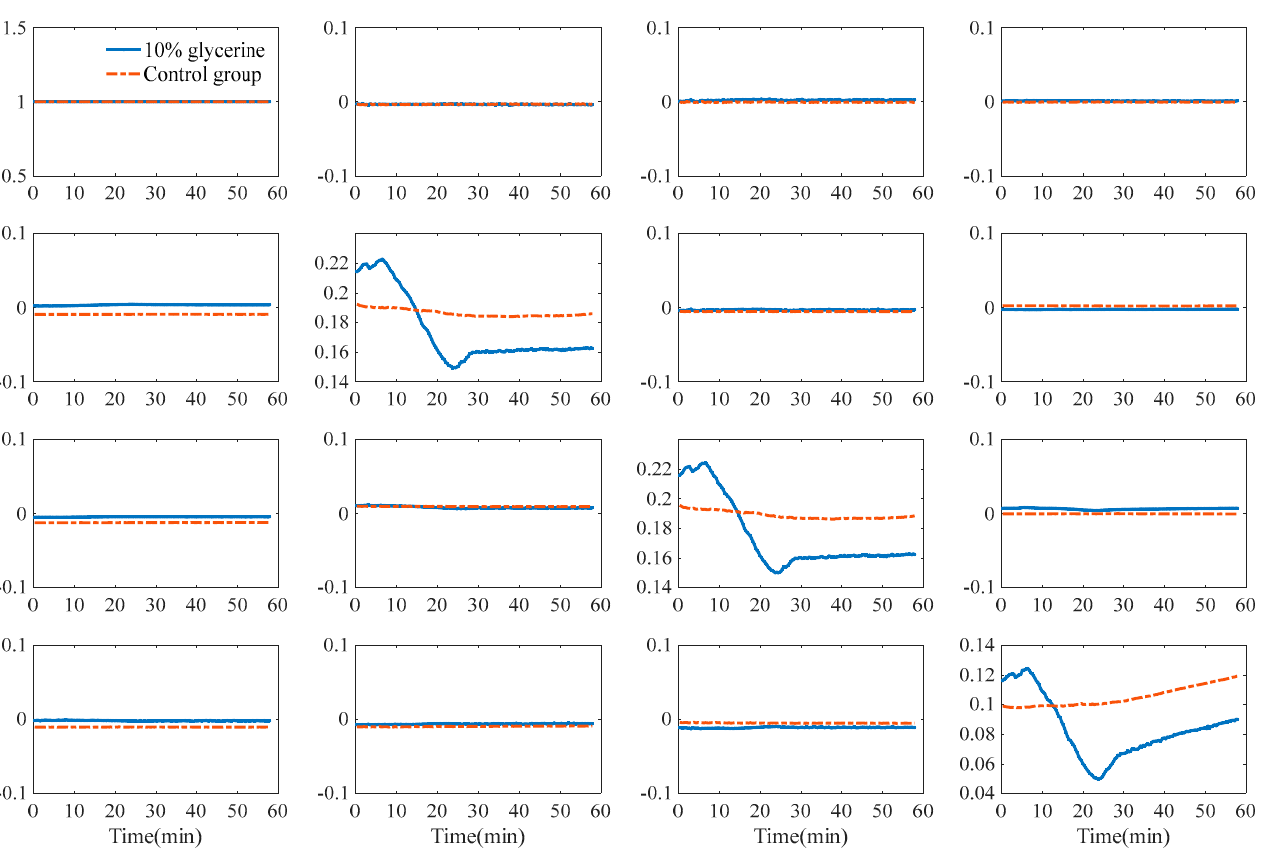
Figure 7. Average values elements of MM of double-layer tissue at different treatment: application of 10% glycerin (blue lines) and control group (red line). The horizontal axis represents the time after different